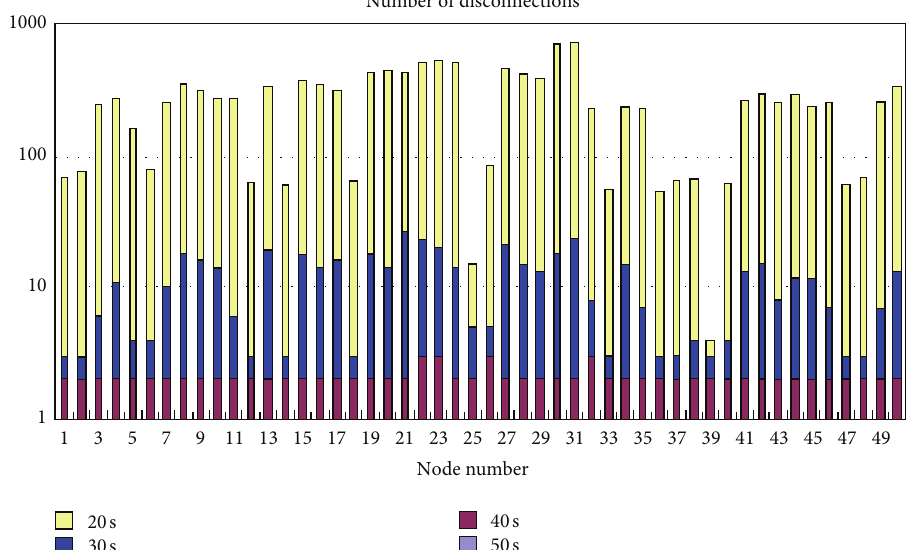
Figure 11: Number of disconnections for each node with varied time interval.